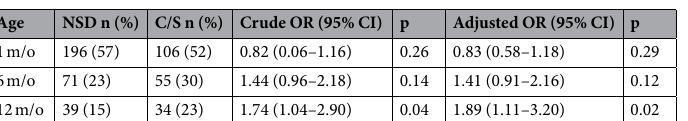
Table 3. Association between mode of delivery and IgE level at birth, and total/specific IgE level at 1 year of age. Adjusted for gestational age, parity, gender, birth body weight, smoking during pregnancy, maternal education, and parental allergy. Cuff-off values: Cord IgE: ≥ 0.5 IU/L. Total IgE: ≥ 97 IU/L. Detectable allergen- specific IgE level: ≥ 0.35 IU/L.